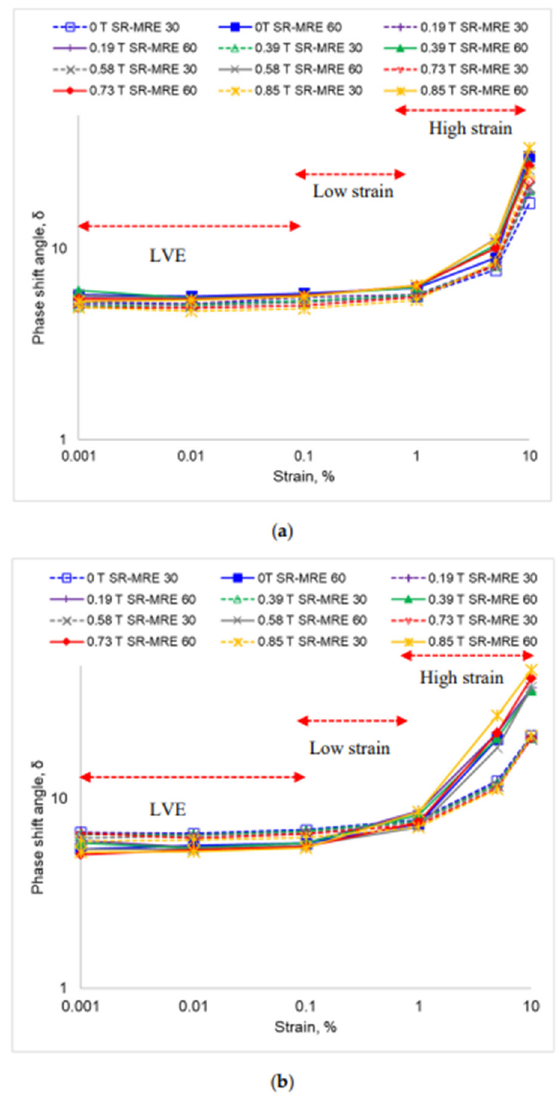
Figure 7. Comparison of phase shift angle of both ( a ) unaged and ( b ) aged SR ‐ MRE samples at different strains and magnetic fields strength .